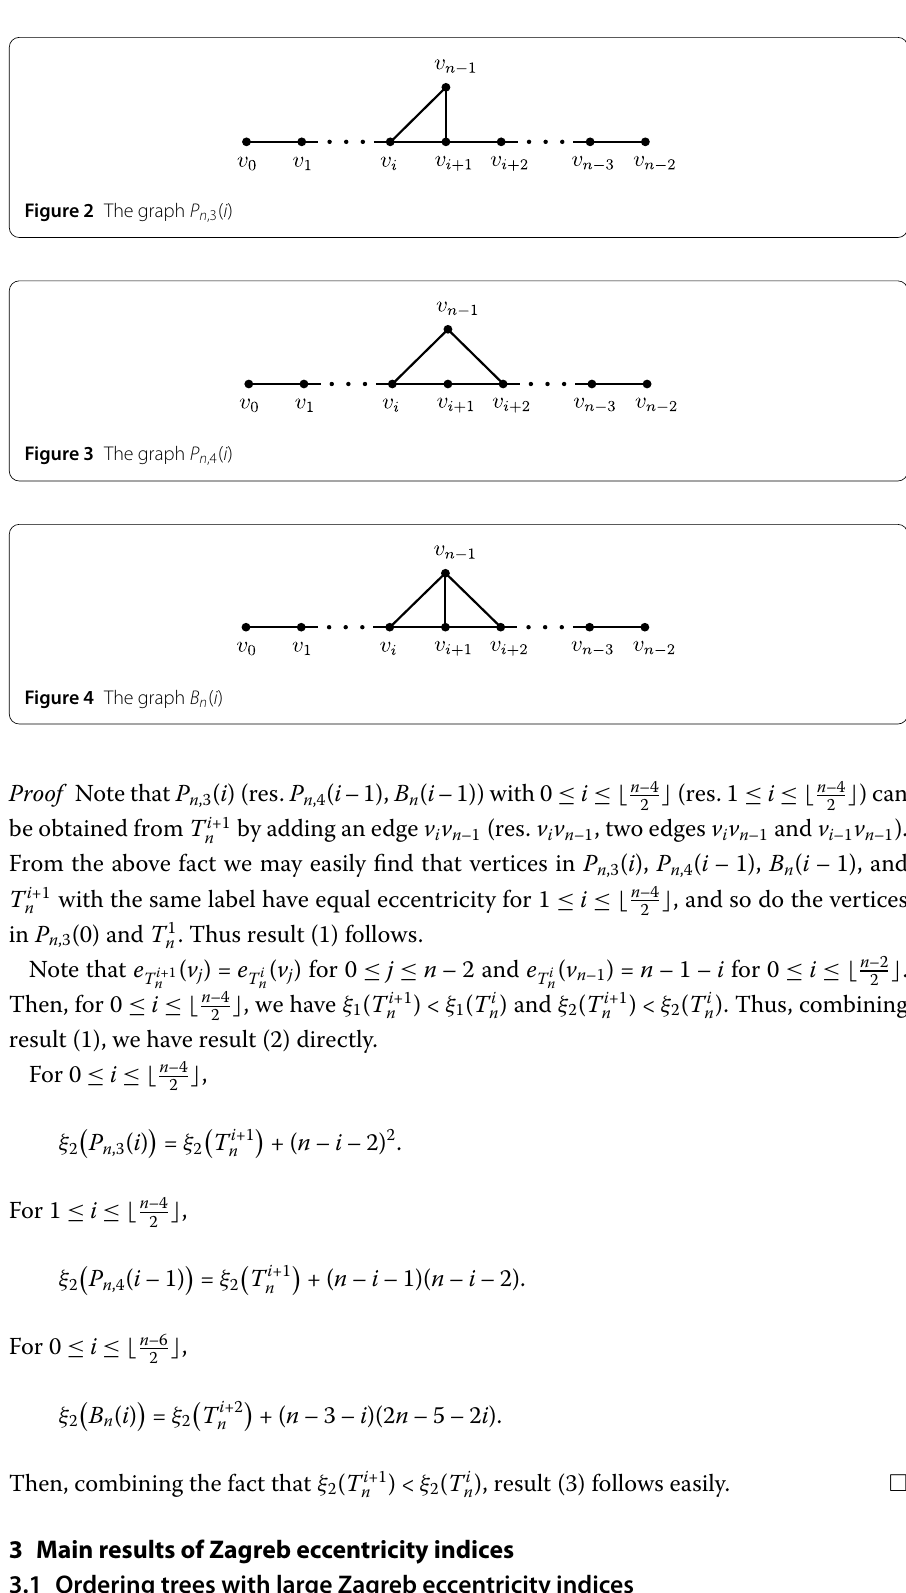
Figure 2 The graph P n ,3 ( i )